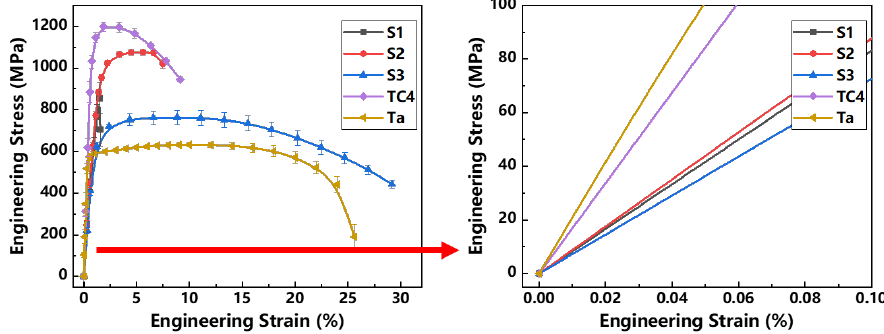
Figure 13. Engineering stress-strain curves of Ti-Ta samples produced by LPBF at various building parameters. The TC4 and pure Ta samples were built as a comparison to Ti-Ta. Table 5. The mechanical properties of Ti-Ta pure Ta and TC4 by LPBF.